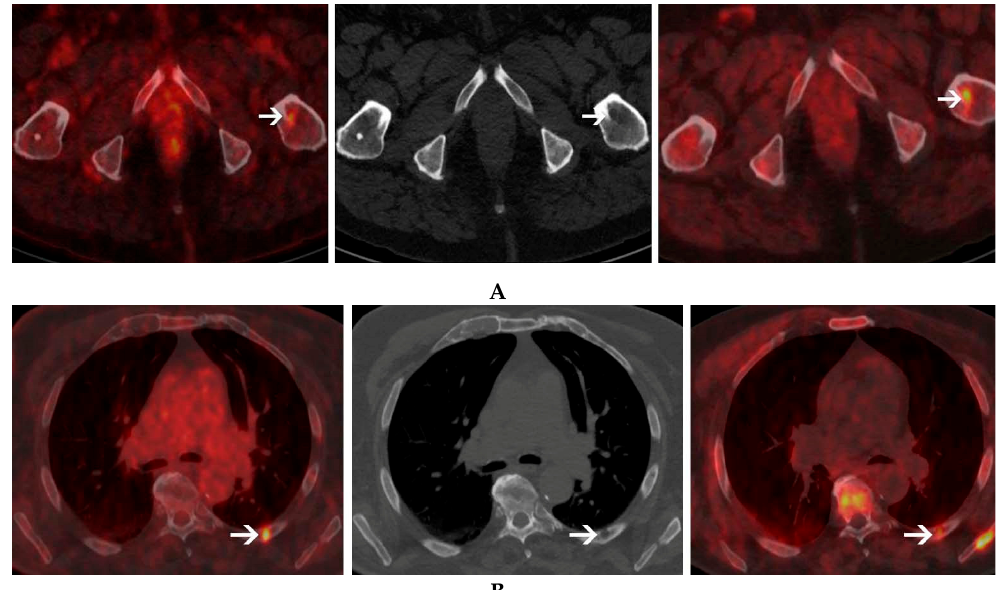
Figure 3. A 72-year-old male with light chain multiple myeloma. 18 FDG PET/CT (left panel) and 18 F-Choline PET/CT (right panel) were performed with a 5-day-interval. Different uptake patterns are seen in this patient. Lesion exhibiting high choline uptake but low FDG uptake can be seen in the left femur ( A ). In contrast, however, a lesion with high FDG uptake but low Choline uptake can be seen in the posterior arch of the left 6th rib ( B ) corresponding to an osteolytic lesion on CT (central panel).